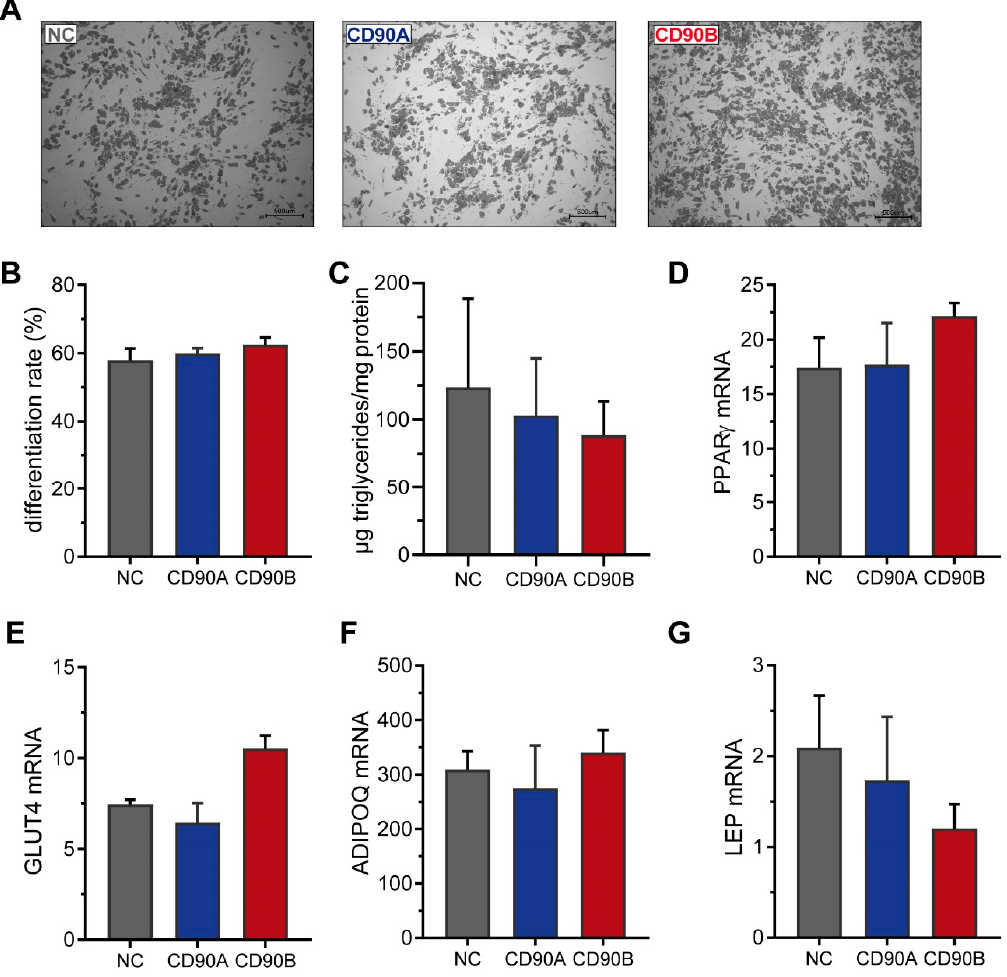
Figure 5. CD90 knockout has no impact on adipogenesis in human SGBS cells. CD90-deficient (CD90A and CD90B) and control (NC sgRNA) SGBS were subjected to adipogenic differentiation. ( A ) (CD90A and CD90B) and control (NC sgRNA) SGBS were subjected to adipogenic di ff erentiation. Representative photomicrographs after 14 days of adipogenic differentiation. Scale bar = 500 µm ( B ) ( A ) Representative photomicrographs after 14 days of adipogenic di ff erentiation. Scale bar = 500 µ m The rate of adipogenic differentiation was determined microscopically. ( C ) The amount of formed ( B ) The rate of adipogenic di ff erentiation was determined microscopically. ( C ) The amount of formed triglycerides was determined. ( D–G ). The mRNA expression of ( D ) PPAR γ , ( E ) GLUT4, ( F ) triglycerides was determined. ( D – G ). The mRNA expression of ( D ) PPAR γ , ( E ) GLUT4 , ( F ) adiponectin ( ADIPOQ ), and ( G ) leptin ( LEP ) was determined by RT-qPCR. TF2B expression was used to normalize the data. Data are displayed as mean ± SEM of 3 independent experiments. No significant di ff erences between groups were detected by one-way ANOVA with Tukey